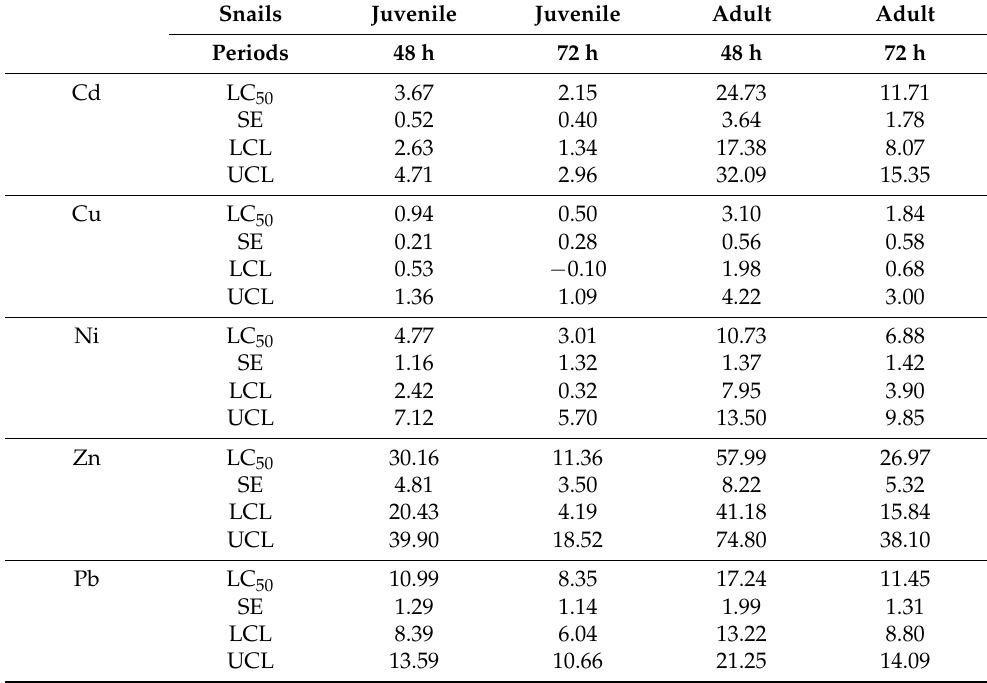
Table 1. Comparisons of the LC 50 values (mg/L) of Cd, Cu, Ni, Pb and Zn in both juveniles and adults Pomacea insularum , in 48 h and 72 h of exposure, with their standard errors (SE), upper confidential limits (UCL) and lower confidential limits (LCL) of the obtained LC 50 values.